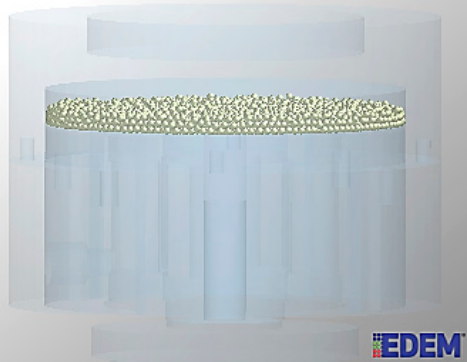
Figure 13. The model of particle damping sensor in EDEM.